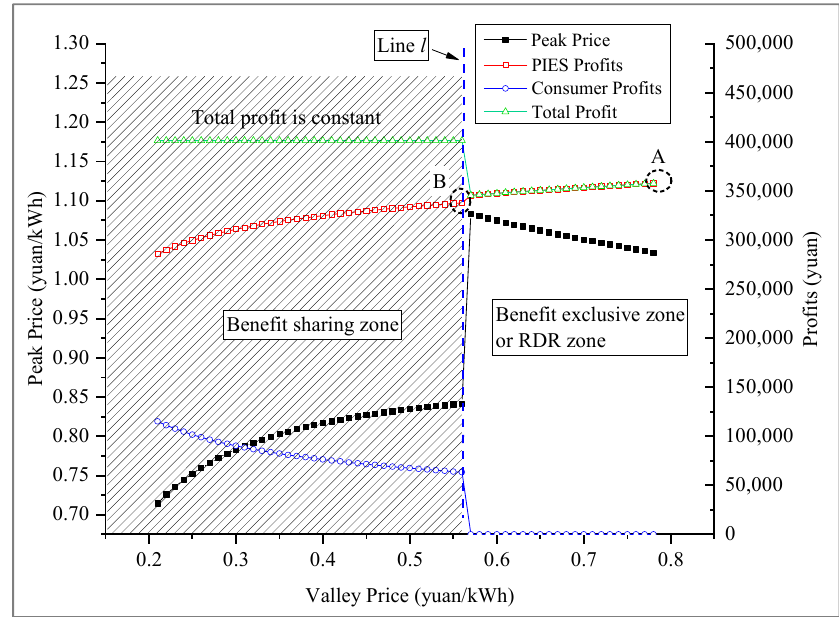
Figure 12. Results of valley price, peak price, and profit.